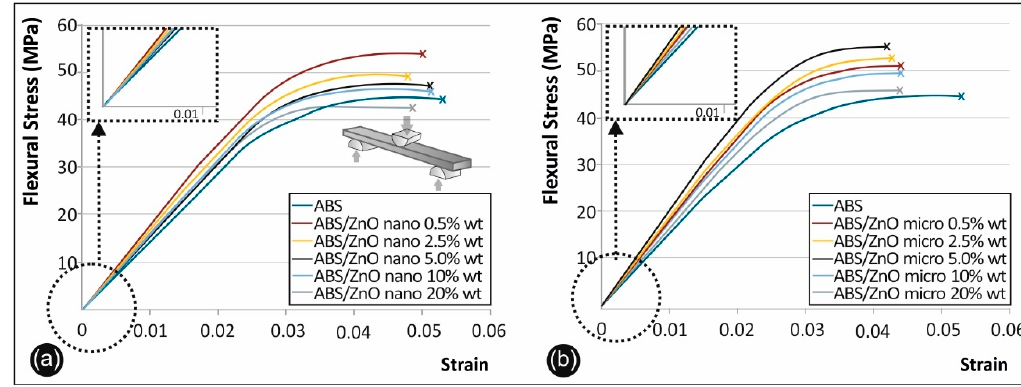
Figure 9. ( a ) Flexure stress vs. strain graphs for ( b ) ABS/ZnO nano and ABS/ZnO micro.